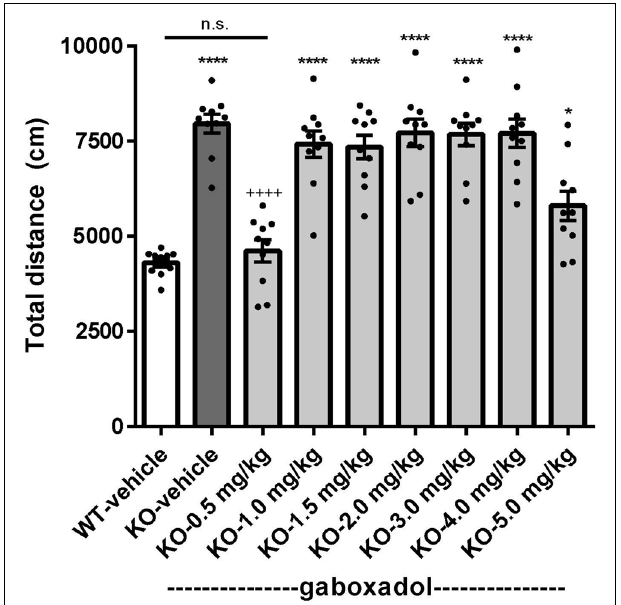
FIGURE 2 | Gaboxadol normalizes anxiety-related behaviors in Fmr1 KO2 mice. WT mice treated with vehicle (white bar), Fmr1 KO2 mice treated with vehicle (KO, dark gray bar), or Fmr1 KO2 mice treated with gaboxadol (KO-0.5–5.0 mg/kg, light gray bars) were subjected to the open field test (OFT), light/dark exploration test (LDT), and successive alleys test (SAT). (A) Total distance traveled in the center of the OFT. (B) The number of transitions between light and dark compartments in the LDT. (C) The number of entries into Alley 1 during the SAT. (D) The number of entries into Alley 2 during the SAT. Bars are means ± SEM, dots are raw data from individual mice. ∗∗∗∗ p < 0.0001, ∗∗∗ p < 0.001, ∗∗ p < 0.01, ∗ p < 0.05 vs. WT-vehicle group; ns, not significant vs. WT-vehicle group; ++++ p < 0.0001, +++ p < 0.001, ++ p < 0.01 vs. Fmr1 KO2 vehicle group. N = 10 per